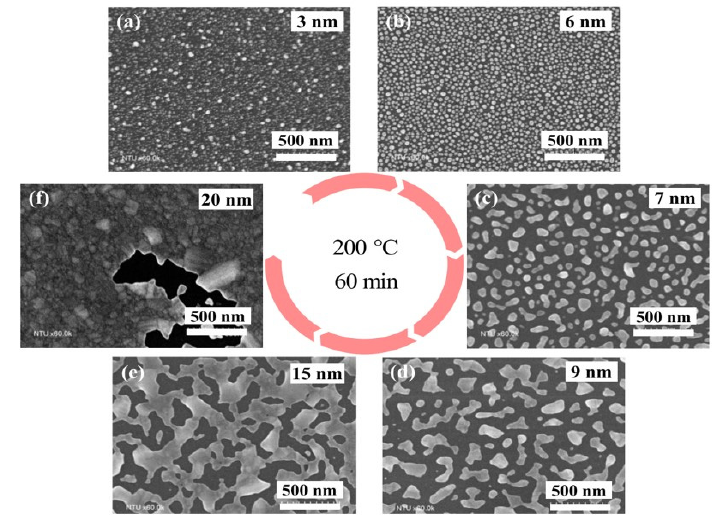
Figure 4. The SEM images of the dewetted results of the silver films with an original thickness of ( a ) 3 nm, ( b ) 6 nm, ( c ) 7 nm, ( d ) 9 nm, ( e ) 15 nm, and ( f ) 20 nm.